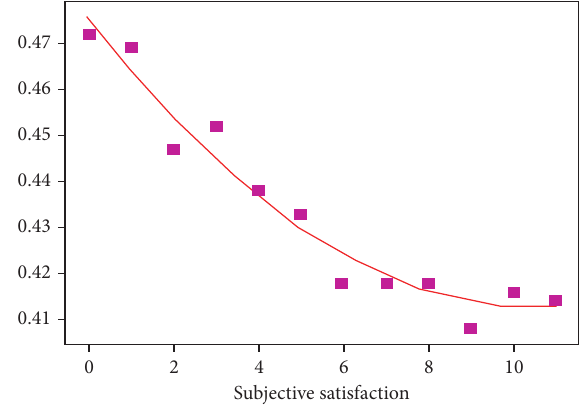
Figure 2: Goodness-of-fit test results.